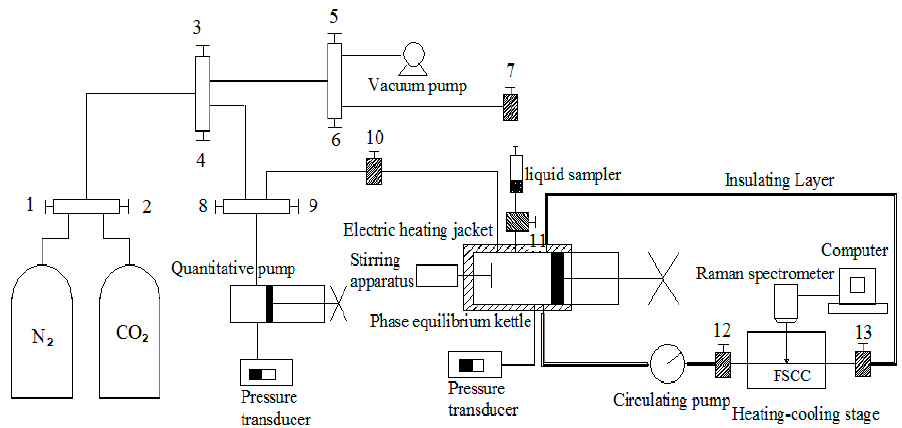
Figure 1. Schematic diagram of the measurement apparatus of the solubility of CO 2 in n -decane and n -decane + n -hexane system.